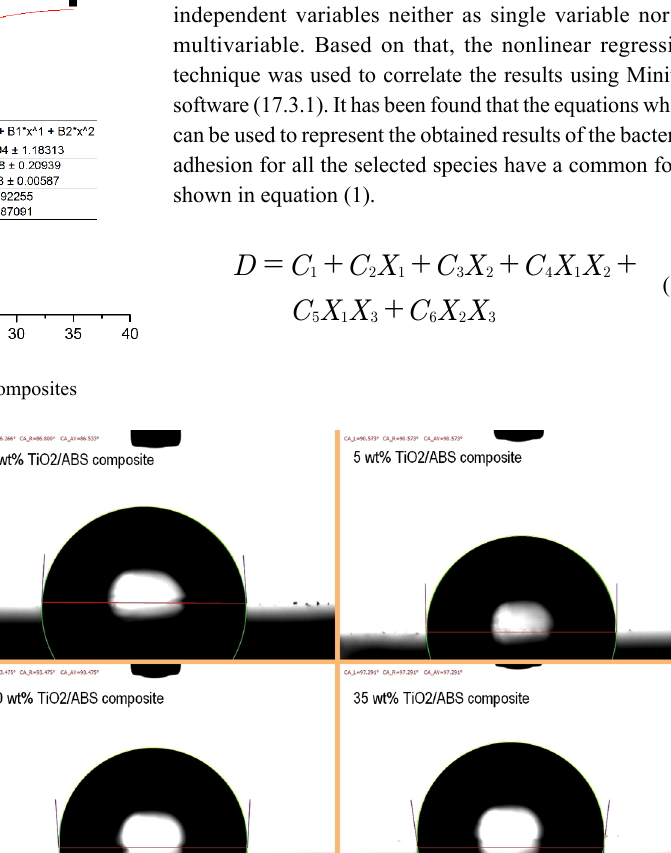
/ABS composites 2